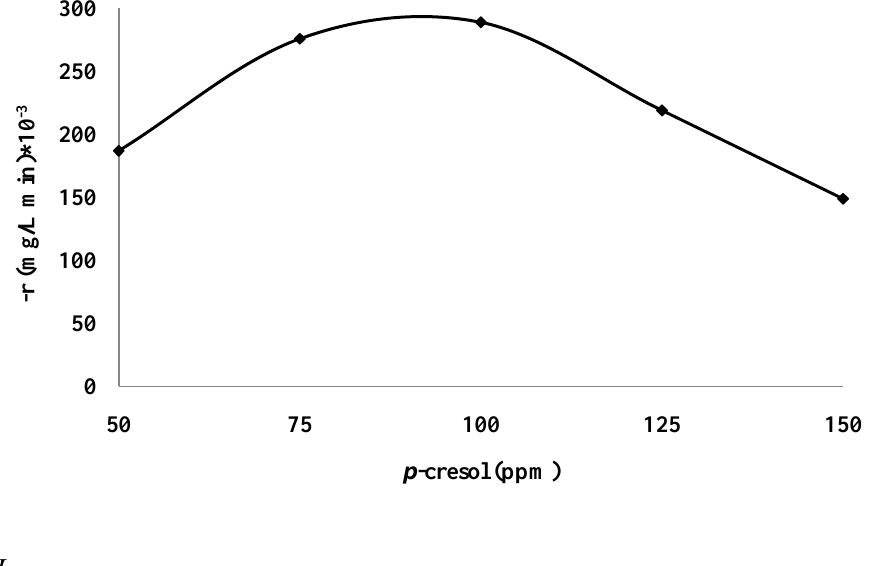
Figure 4. Rate constants (r) of photodegradation of different p -cresol concentrations under UV irradiation. Initial condition: ZnO = 2.5g/L, pH = 7.49, at 25 °C (Derived